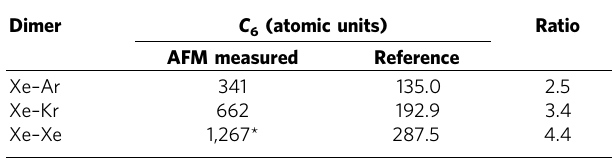
Table 1 | Comparison of C 6 coefficients fitted to AFM measurements and theoretical reference 39